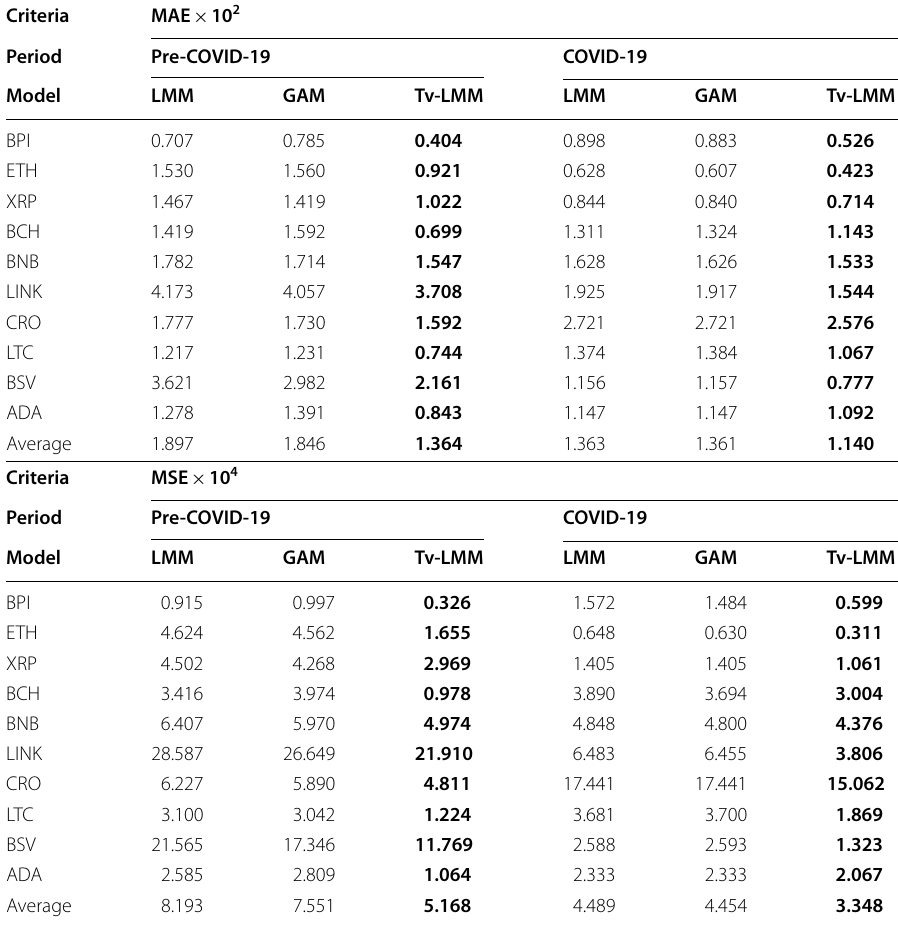
Bold values indicate the best predictability performance for cryptocurrency price in terms of the lowest MAE and MSE,